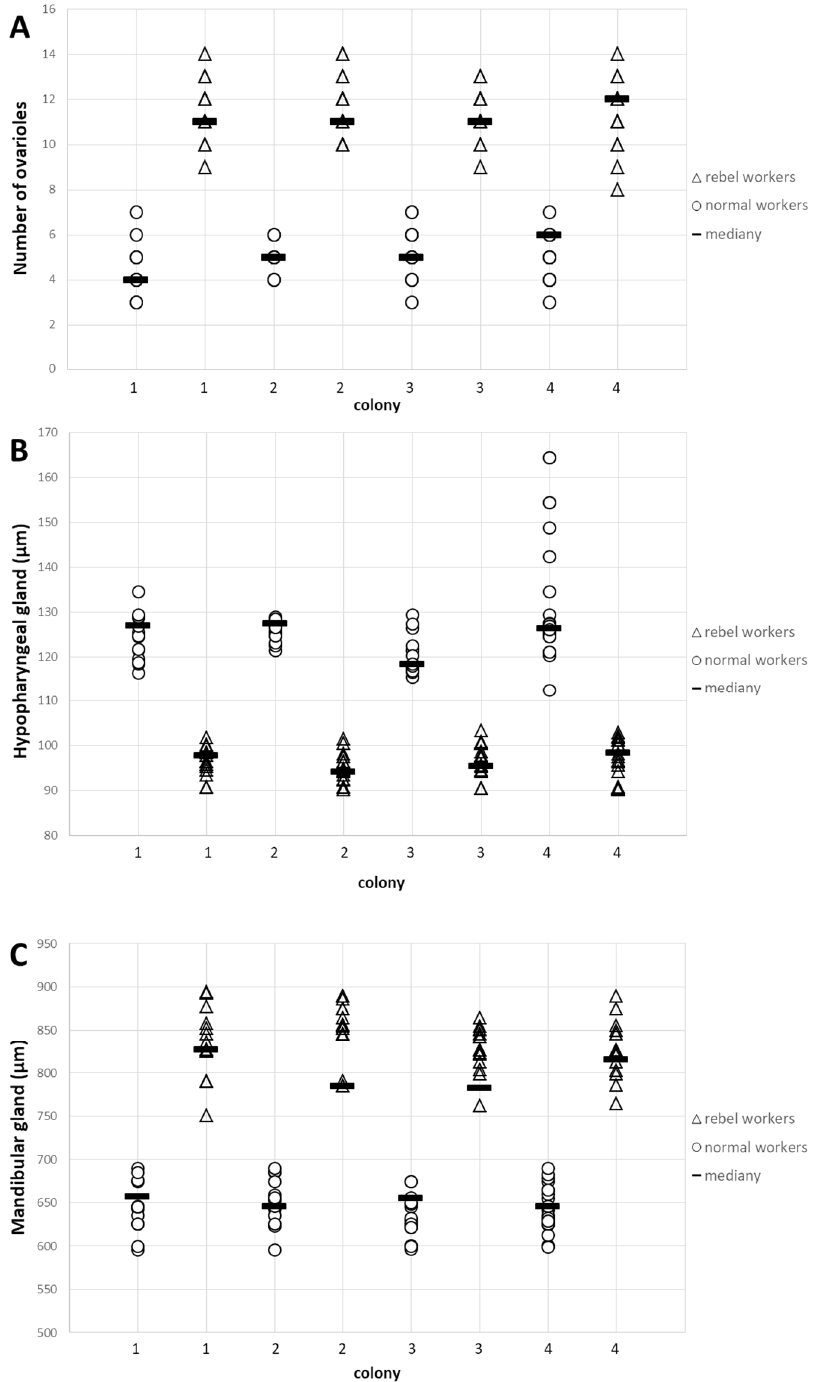
Figure 2. Anatomical characteristics of newly emerged honeybee rebel and normal workers. ( A ) number of ovarioles (colony: rebel workers p = 0.98, Kruskal–Wallis test; normal workers p = 0.08, Kruskal–Wallis test; rebel workers + normal workers p = 0.71, Kruskal–Wallis test), ( B ) size of hypopharyngeal glands (colony: rebel workers p = 0.36, Kruskal–Wallis test; normal workers p = 0.00, Kruskal–Wallis test; rebel workers + normal workers p = 0.12, Kruskal–Wallis test), ( C ) size of mandibular glands (colony: rebel workers p = 0.08, F3.66 = 2.36, ANOVA; normal workers p = 0.25, Kruskal–Wallis test; rebel workers + normal workers p = 0.21, Kruskal–Wallis test). No. of rebel workers = 70; No. of normal workers = 73.